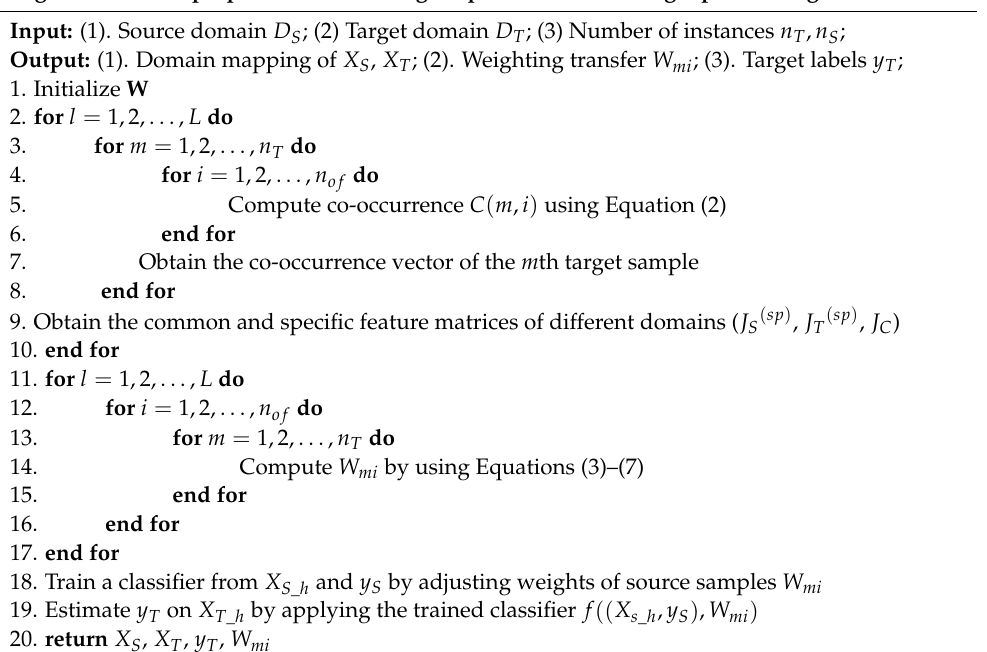
Algorithm 2. The proposed transfer weight optimization and target